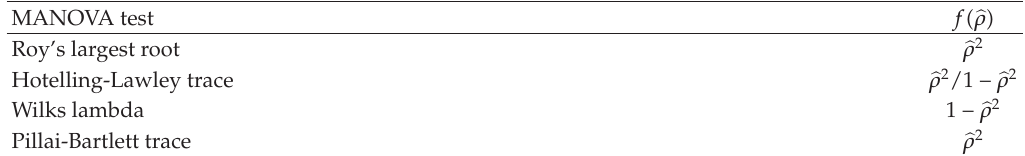
Table 1: Relationship between MANOVA test statistics and canonical correlation for association test of multivariate phenotype and a genetic marker. MANOVA